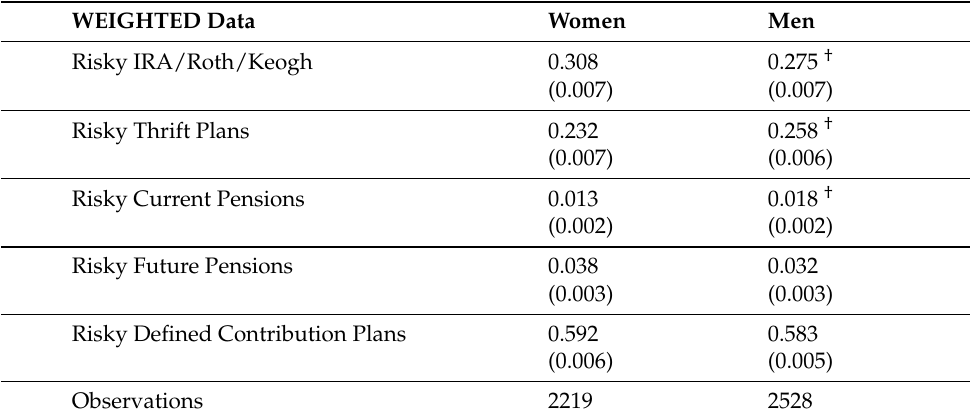
Table 10. Mean Risky Shares of Females and Males in the Extended SCF 2019